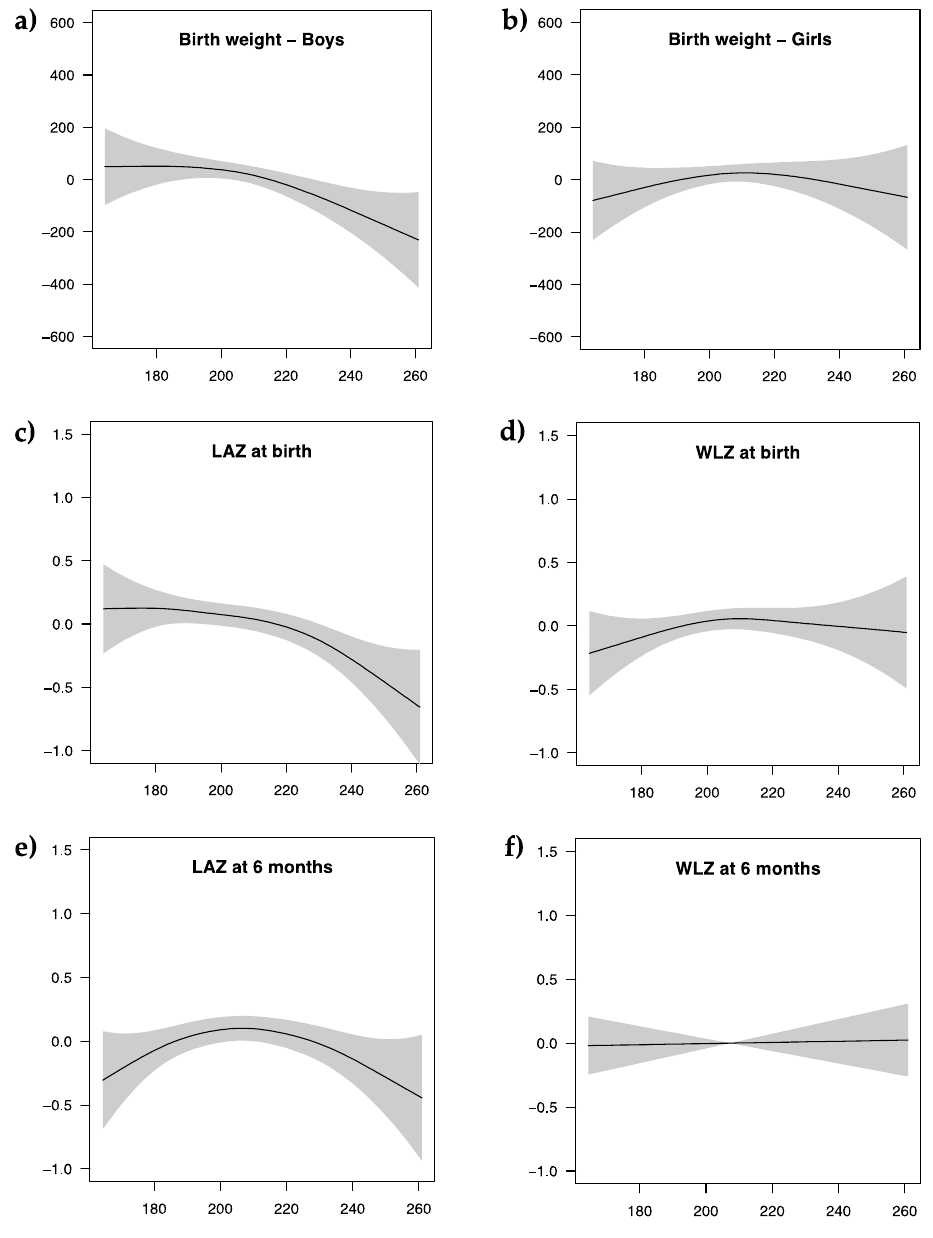
Figure 1. Generalized additive model (GAM) plots showing: the relation of maternal plasma total cysteine (tCys) concentration with birth weight (in grams) among boys ( a ) and girls ( b ); length-for-age Z-score (LAZ) at birth ( c ); weight-for-length Z-score (WLZ) at birth ( d ); LAZ score at six months of age ( e ); and WLZ score at six months of age ( f ) after adjusting for confounders included in the regression models and excluding values <2.5th percentile and ≥ 97.5th percentile for maternal tCys. Y-axes values for all the growth indicators are centered around their respective median.